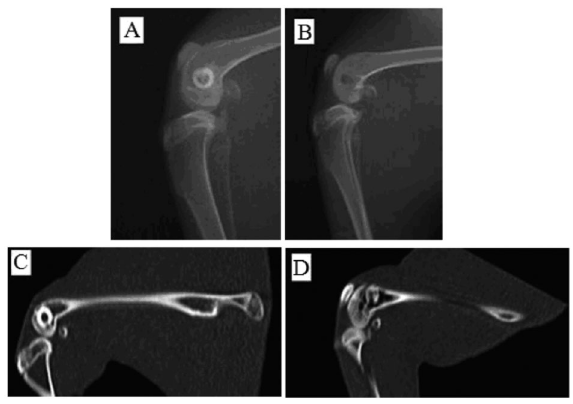
Figure 9. Radiographs of MAO-coated magnesium ( A ) and uncoated magnesium ( B ) implants after 8 weeks post-operation; and CT images of MAO-coated magnesium ( C ) and uncoated magnesium ( D ) implants after 12 weeks post-operation. MAO: micro-arc